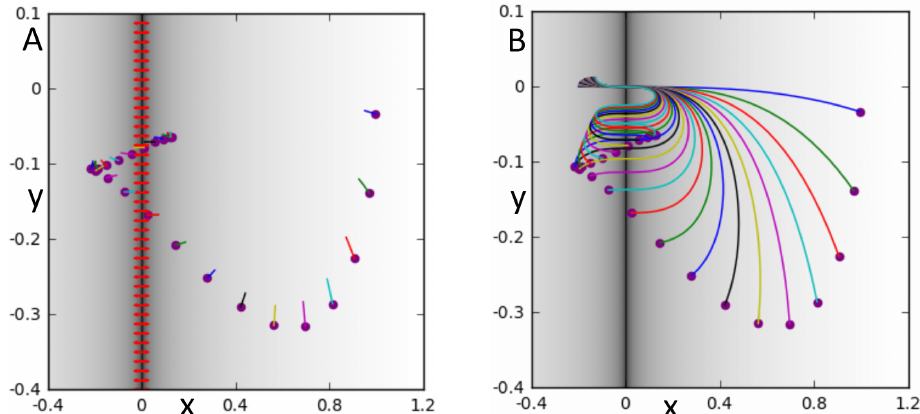
Figure 6: Example demonstrating that distinct geodesics can agree in both position and velocity (orientation of the tangent vector) at a singular point. The manifold is the “linear dreibein wall” treated in Sec. 5, and the null geodesics have the closed form solution given by Eqs. (66a) and (66b). A: Several geodesics are launched at t = 0 (launch points marked with circles) in the vicinity of a nematic singularity wall along the line x = 0, with a horizontal collimation direction (marked with arrows). B: At t = 1, all geodesics simultaneously pass through the origin at the correct col- limation velocity, as dictated by singularity. All 25 distinct geodesics have the same instantaneous position and velocity at t = 1. After traversing the singularity, these mutually diverge (remain distinct) in their subsequent evolution along the